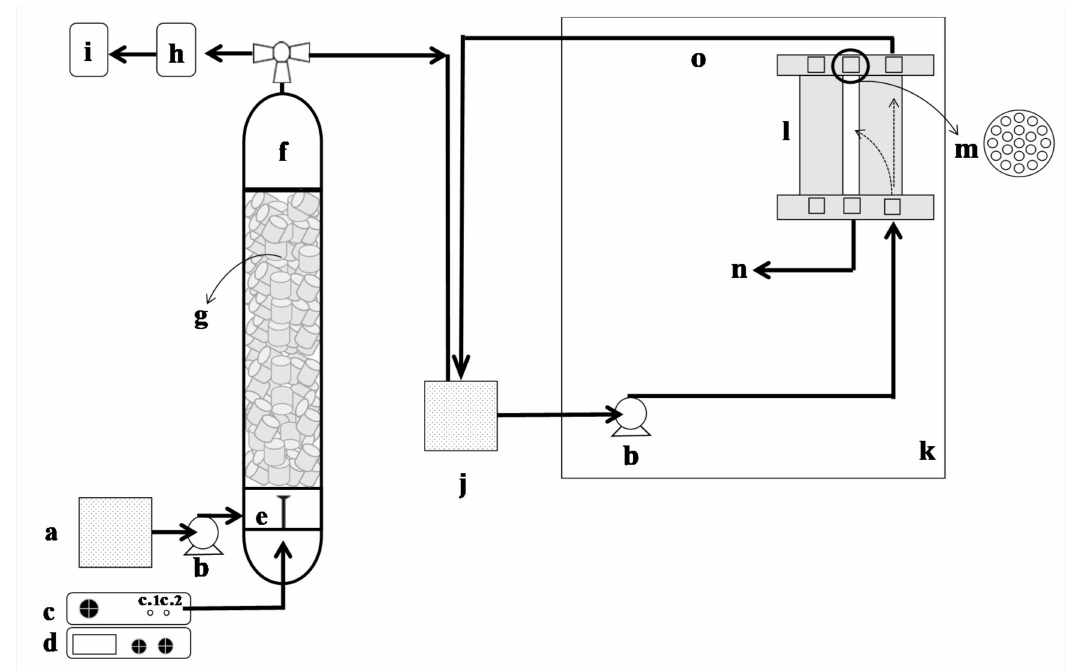
Figure 1. Scheme of the experimental apparatus. ( a ) feed tank containing deionised water or UWWTP e ffl uent; ( b ) peristaltic pump; ( c ) ozone generator (c.1—O 2 entrance; c.2—O 3 exit); ( d ) mass flow controller; ( e ) ozone di ff user; ( f ) packed-bed column; ( g ) Raschig rings; ( h ) ozone